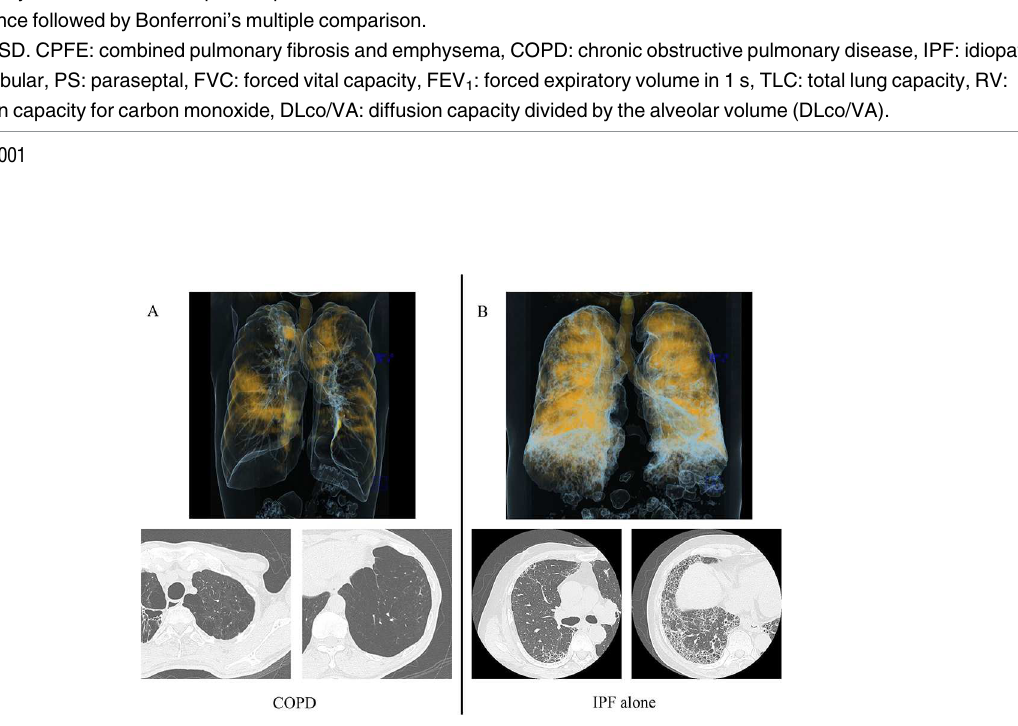
Fig 2. Image analysis of ventilation defect in COPD and IPF alone. (A) COPD shows largely focal xenon ventilation defects.(B) IPF alone shows slightly decreased xenon ventilation with several defects and volume loss with diffuse hypoventilation in the fibrotic lesion.